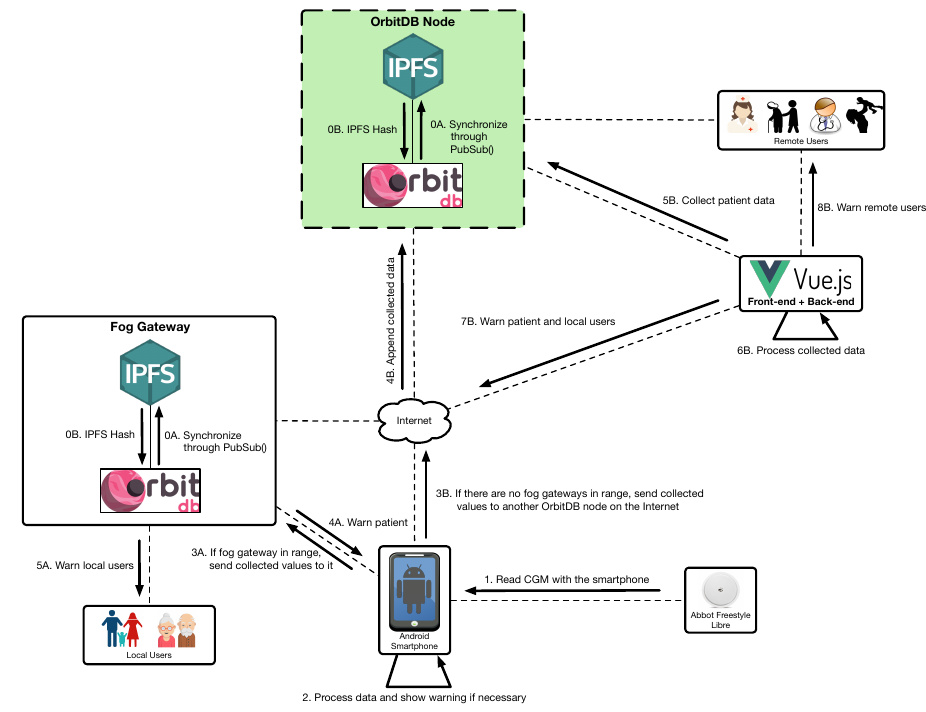
Figure 7. Patient and user notification